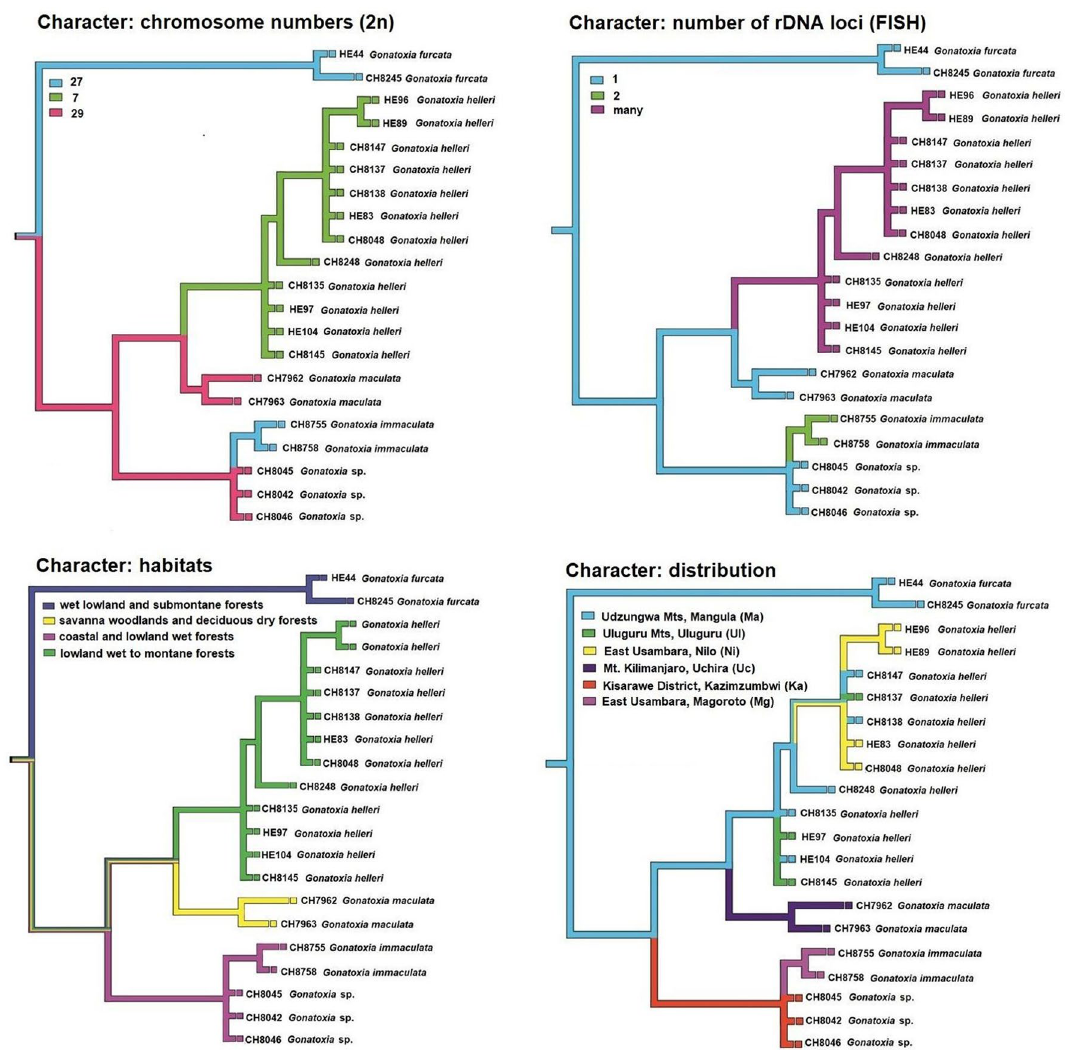
Figure 4. Mapping of chromosome characters, habitats and distribution onto the phylogenetic tree of Gonatoxia species. State reconstruction was estimated using the pruned phylogenetic tree topology from Fig.